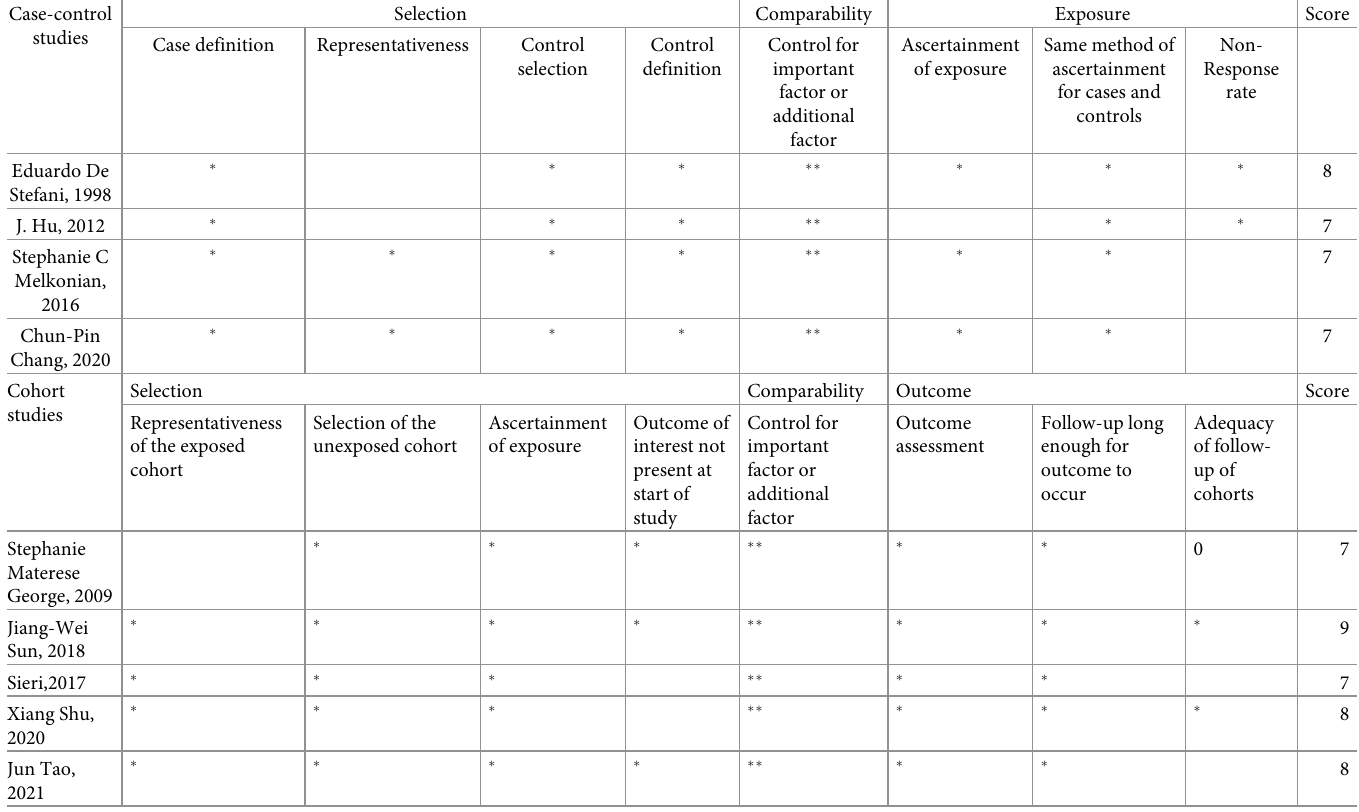
Table 2. Methodological quality of studies included in the meta-analysis.